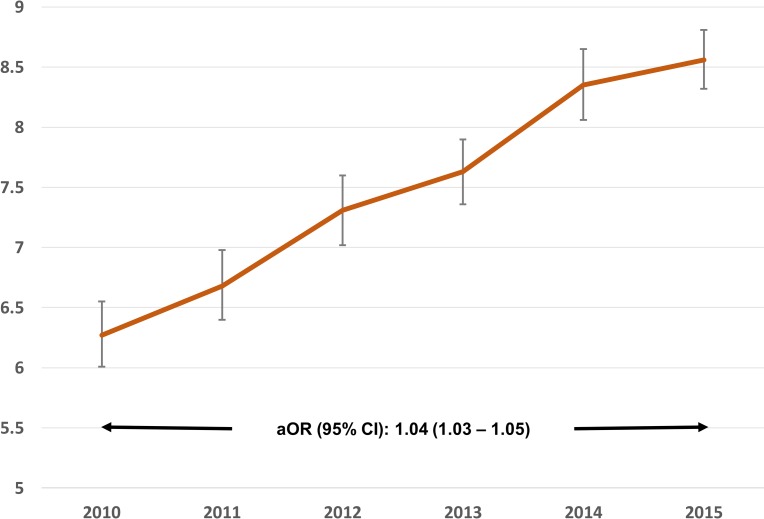
Proportion of stroke patients coded as delirium per year of analysis.Error bars indicate 95% confidence interval of the proportion. Year-wise change in proportion of ischemic and hemorrhagic stroke patients diagnosed and coded as having in-hospital delirium from the Nationwide Readmission Database between 2010 and 2015. The reported odds ratio and 95% confidence interval obtained from survey design logistic regression model control for patient demographic, comorbidity, and disease severity factors.